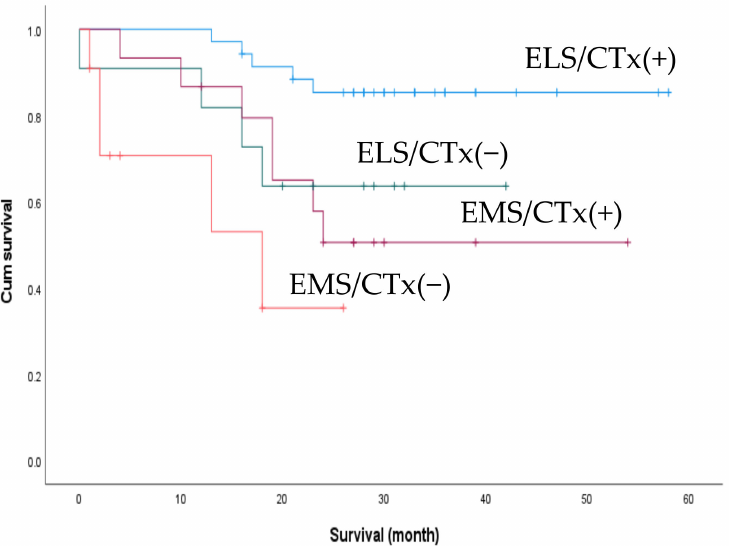
Figure 5. C Comparison of 2-year overall survival between patients who received postoperative adjuvant chemotherapy (post-op CTx) and those who did not. ELS/CTx(+), elective surgery + post-op CTx; ELS/CTx( − ), elective surgery + no post-op CTx; EMS/CTx(+), emergency surgery + post-op CTx; EMS/CTx( − ), emergency surgery + no post-op